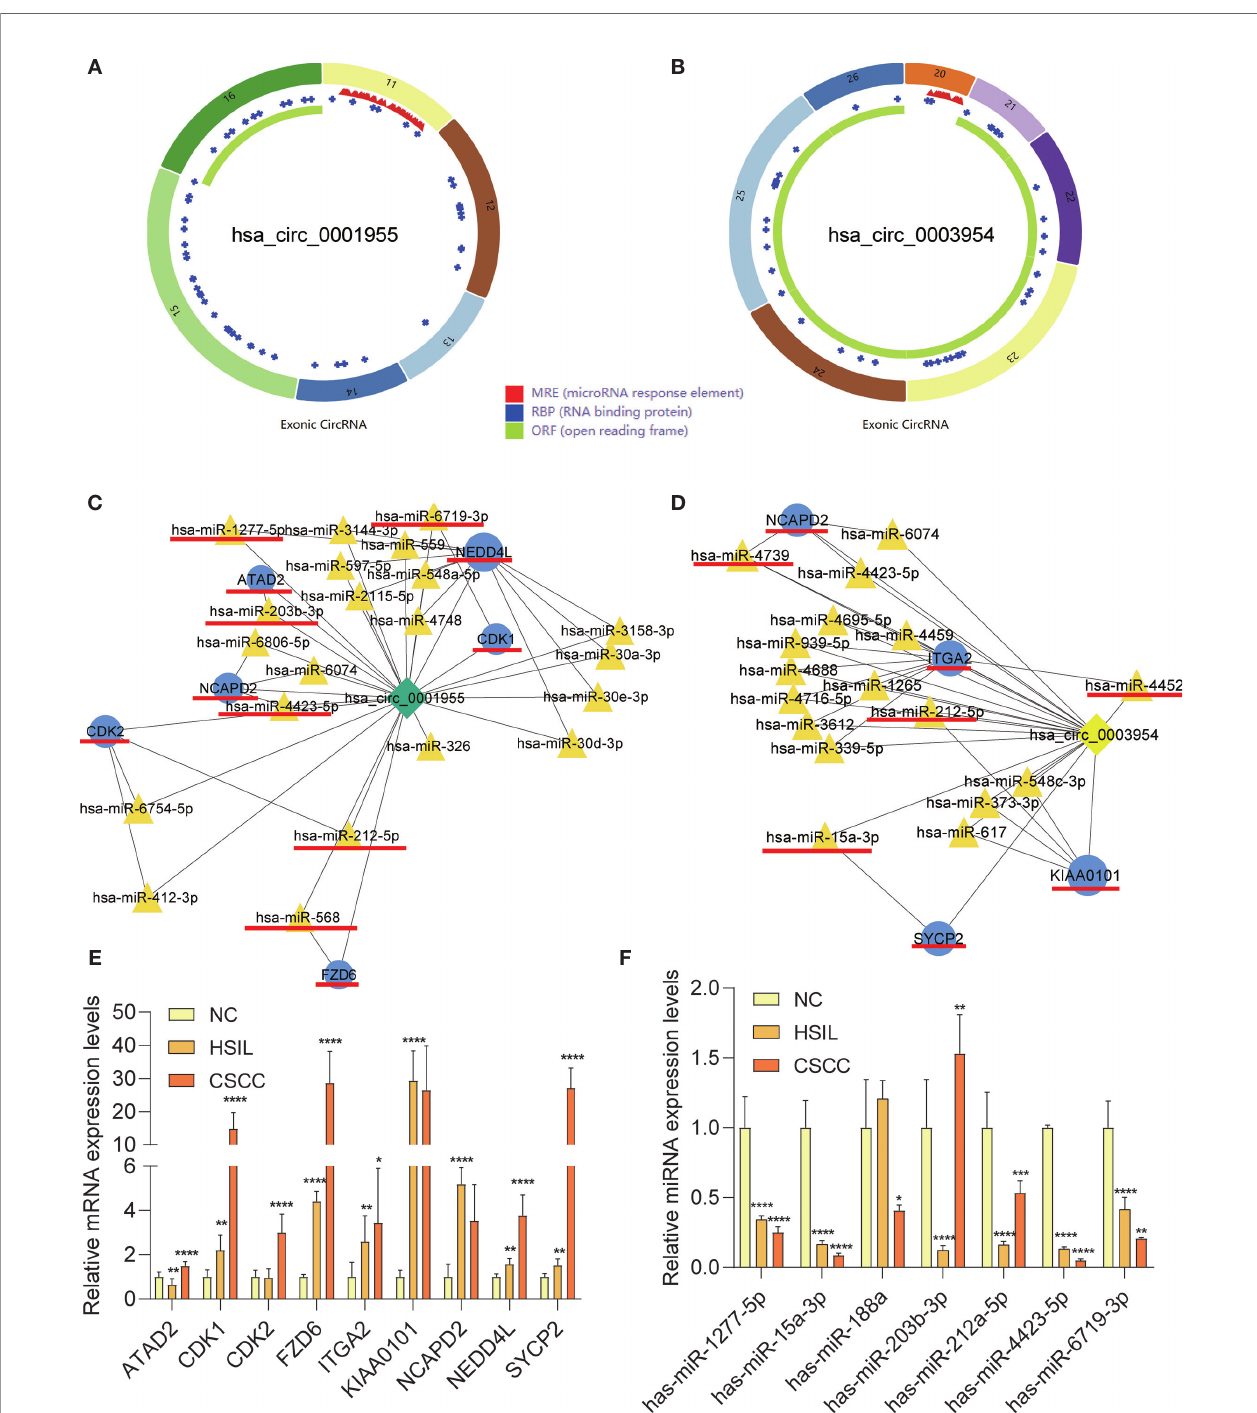
FIGURE 9 | Characteristics of the two circRNAs as determined by the Cancer-speci fi c Circular RNAs database (CSCD) and qRT-PCR results of mRNAs and miRNAs in clinical specimens. (A) The structural pattern of hsa_circ_0001955. (B) The structural pattern of hsa_circ_0003954 (MRE in red, RBP in blue, ORF in green). (C) Hsa_circ_0001955-targeting mRNAs and miRNA. (D) Hsa_circ_0003954-targeting mRNAs and miRNA. The mRNAs and miRNAs to be validated are outlined with red lines. (E) qRT-PCR results of 9 mRNAs in clinical specimens. (F) qRT-PCR results of 10 miRNAs in clinical specimens (hsa-miR-4739, hsa-miR- 4452 and hsa-miR-568 were not detected). MRE, microRNA response element; RBP, RNA binding protein; ORF: open reading frame. For qRT-PCR, target mRNAs expression was normalized to GAPDH expression ( D Ct) and miRNAs expression was normalized to U6 expression ( D Ct). The results are presented as the mean ± SD (NC-qRT-PCR, n=5; HSIL-qRT-PCR, n=5; CSCC-qRT-PCR, n=5). * p < 0.05, ** p < 0.01, *** p < 0.001, **** p <